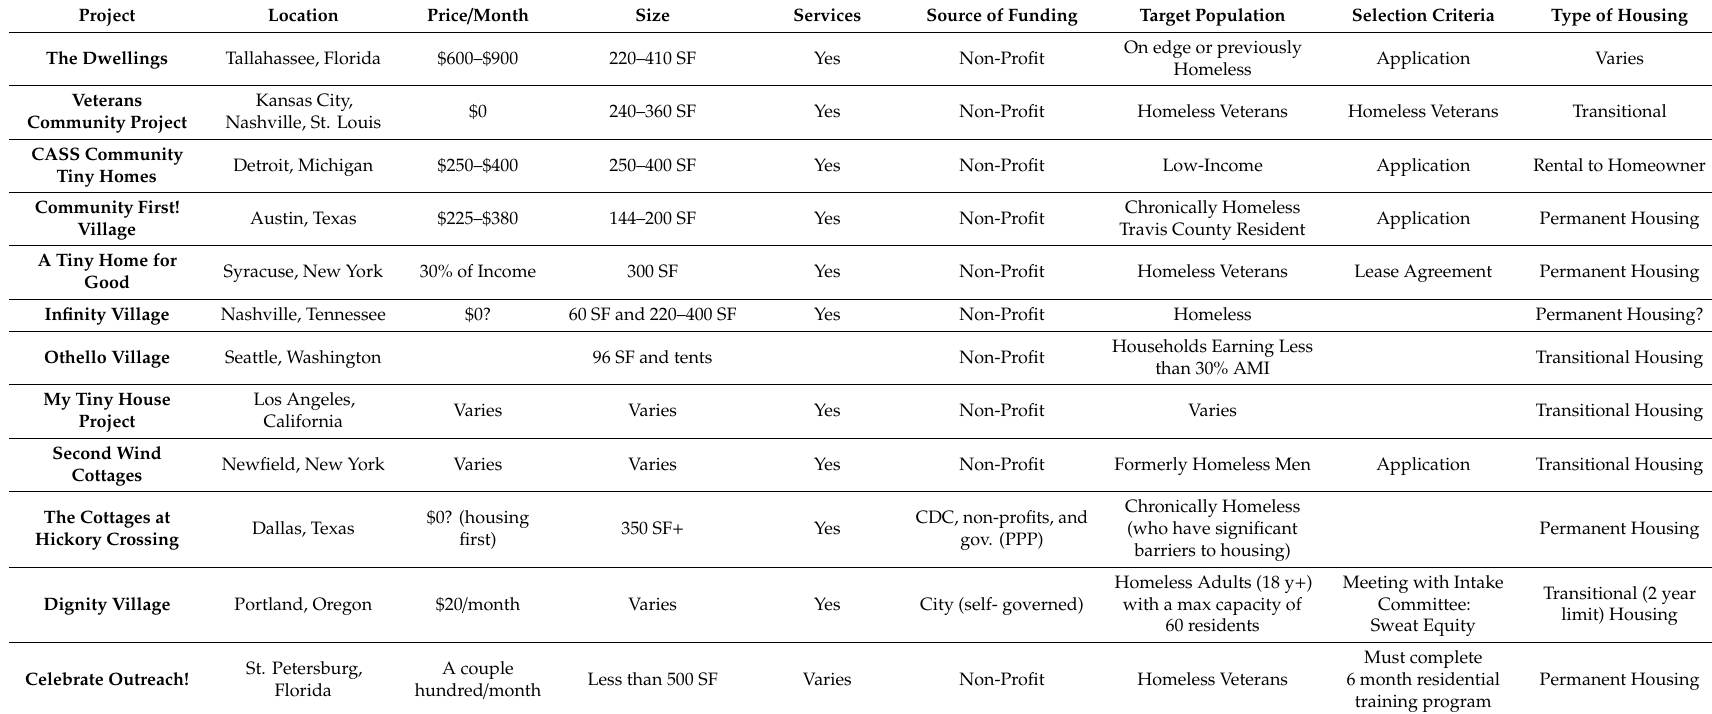
Table 1. Tiny Home Communities Across the United